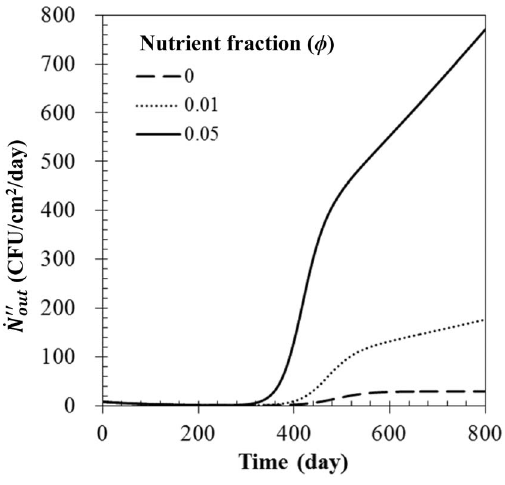
Figure 7. Bioaerosol number flux with various nutrient fractions. Here, g anti =0.5, Q =1.0 m 3 /sec, and C in =100 m g/m 3 .